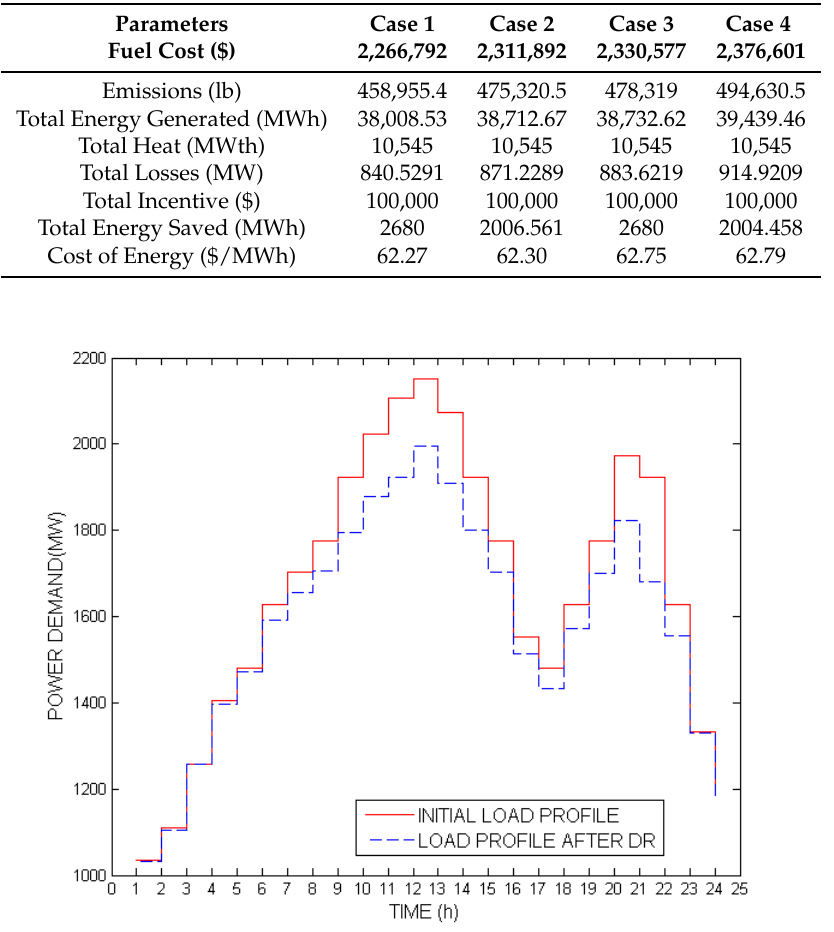
Figure 7. Initial load profile and final load profile after DR for Case